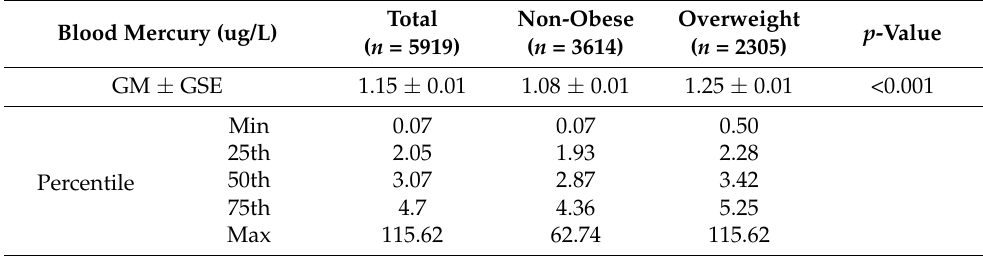
Table 2. Distributions of blood and urinary mercury levels in the study population.